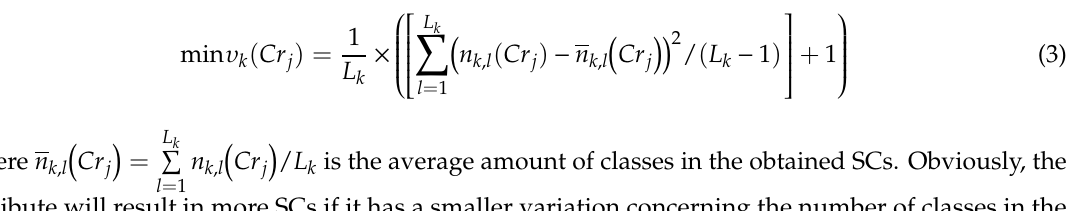
Figure 10. Separability matrix